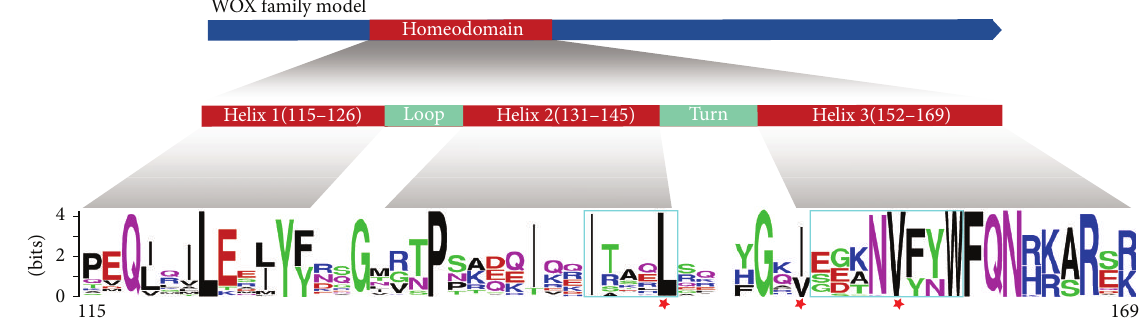
Figure 2: Alignment of the WOX homeodomain sequences. Canonical conserved residues analyzed by WebLogo (Web-based sequence logo generating application; Weblogo.berkeley.edu). The homeodomain of WOX family contained the helix-loop-helix-turn-helix structure [12]. The highly conserved residues are revealed by the alignment of homeodomains, the three highest conserved residues were marked using asterisk, and the residues within the two boxed motifs within the homeodomain marked using azure have close positional correlation which is revealed in Figure